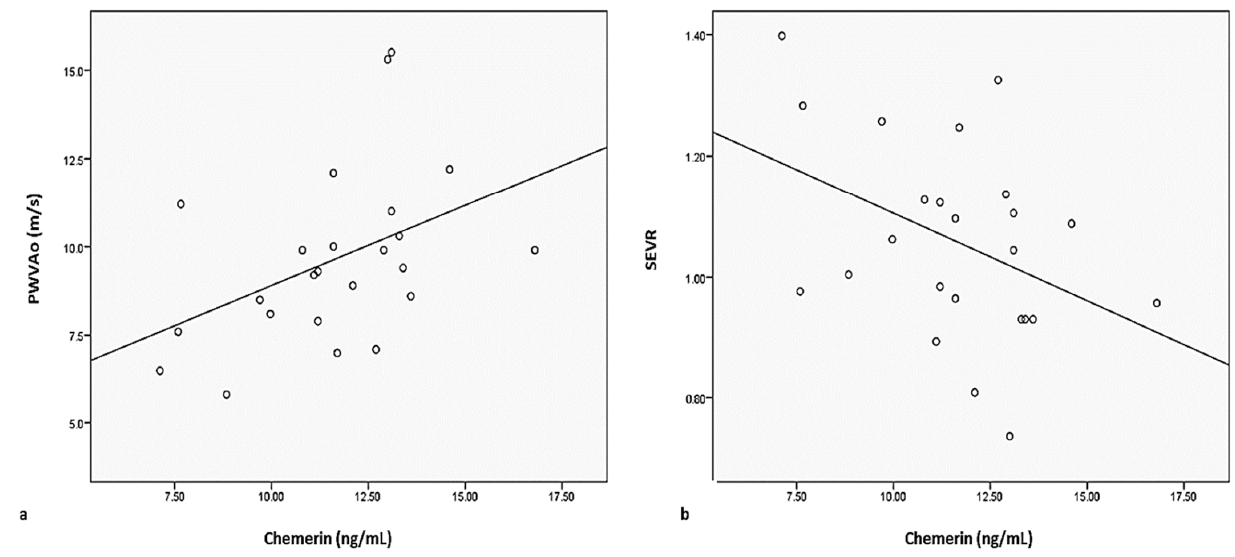
Figure 1. Correlations between serum chemerin levels and ( a ) PWVAo or ( b ) SEVR in patients with morbid obesity (PWVAo: aortic pulse wave velocity; SEVR: subendocardial viability index). Histopathological